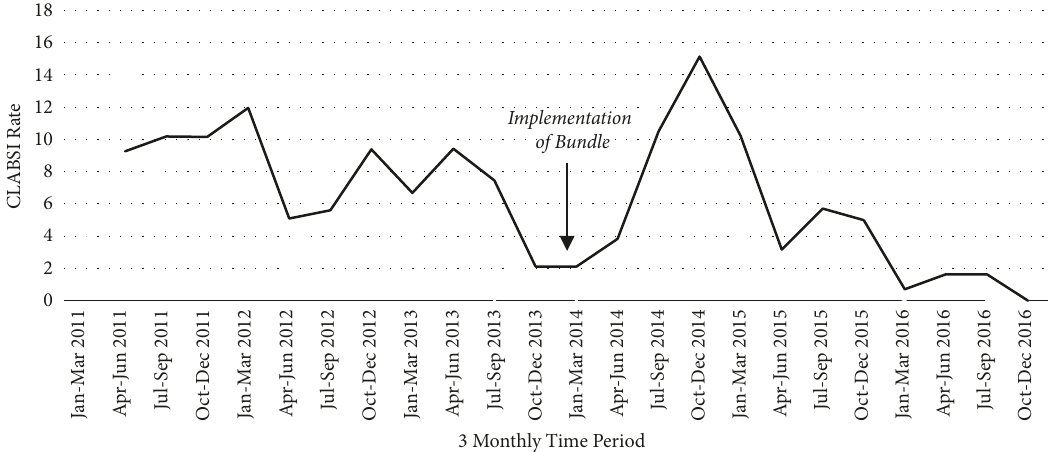
Figure 3: Run chart of Central Line Associated Blood Stream Infections (CLABSI) per 1,000 central line days 2011-2016. Table 1: Characteristics of Infants with central lines Inserted in baseline (2011-2013) and intervention (2014-2016) groups. Characteristic Baseline (n=406) Intervention (n=331) Male sex, % 55.4 57.4